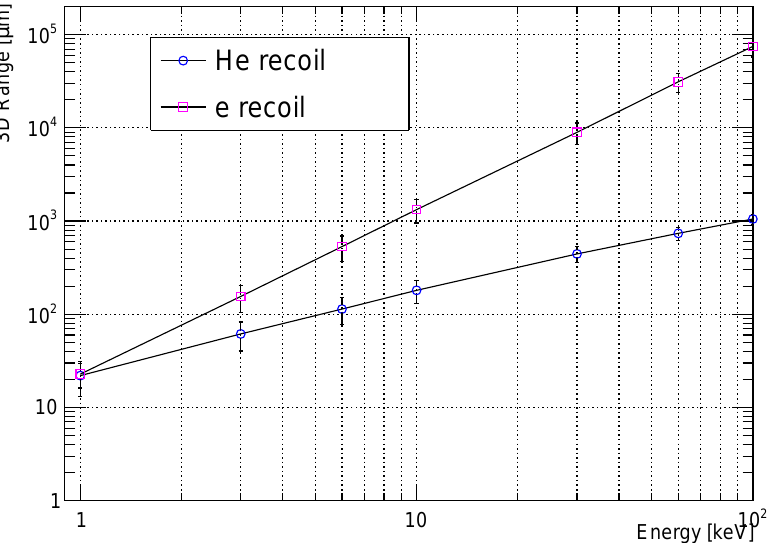
Figure 3. Average 3D distance between the production and absorption point for electron- and He-nucleus recoils as a function of their kinetic energy in a He/CF 4 (60/40) gas